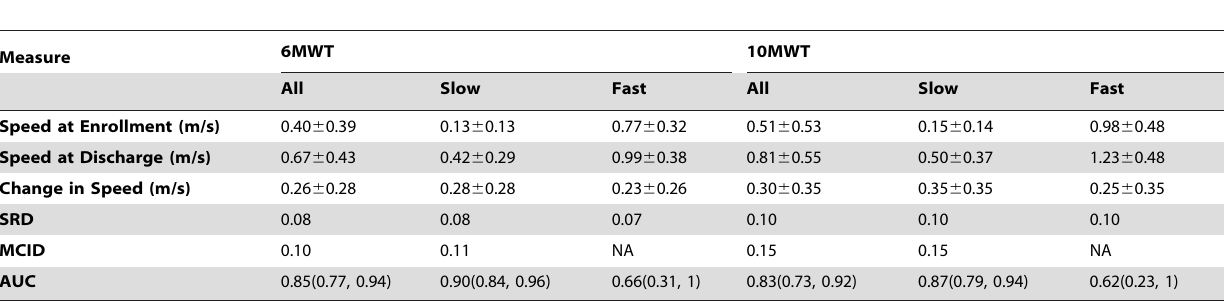
Table 4. Walking speeds at enrollment and discharge (m/s), smallest real difference (SRD), minimal clinically important difference (MCID), and area under the curve (AUC) calculated for 6MWT and 10MWT (in m/s), all and by speed group at enrollment.